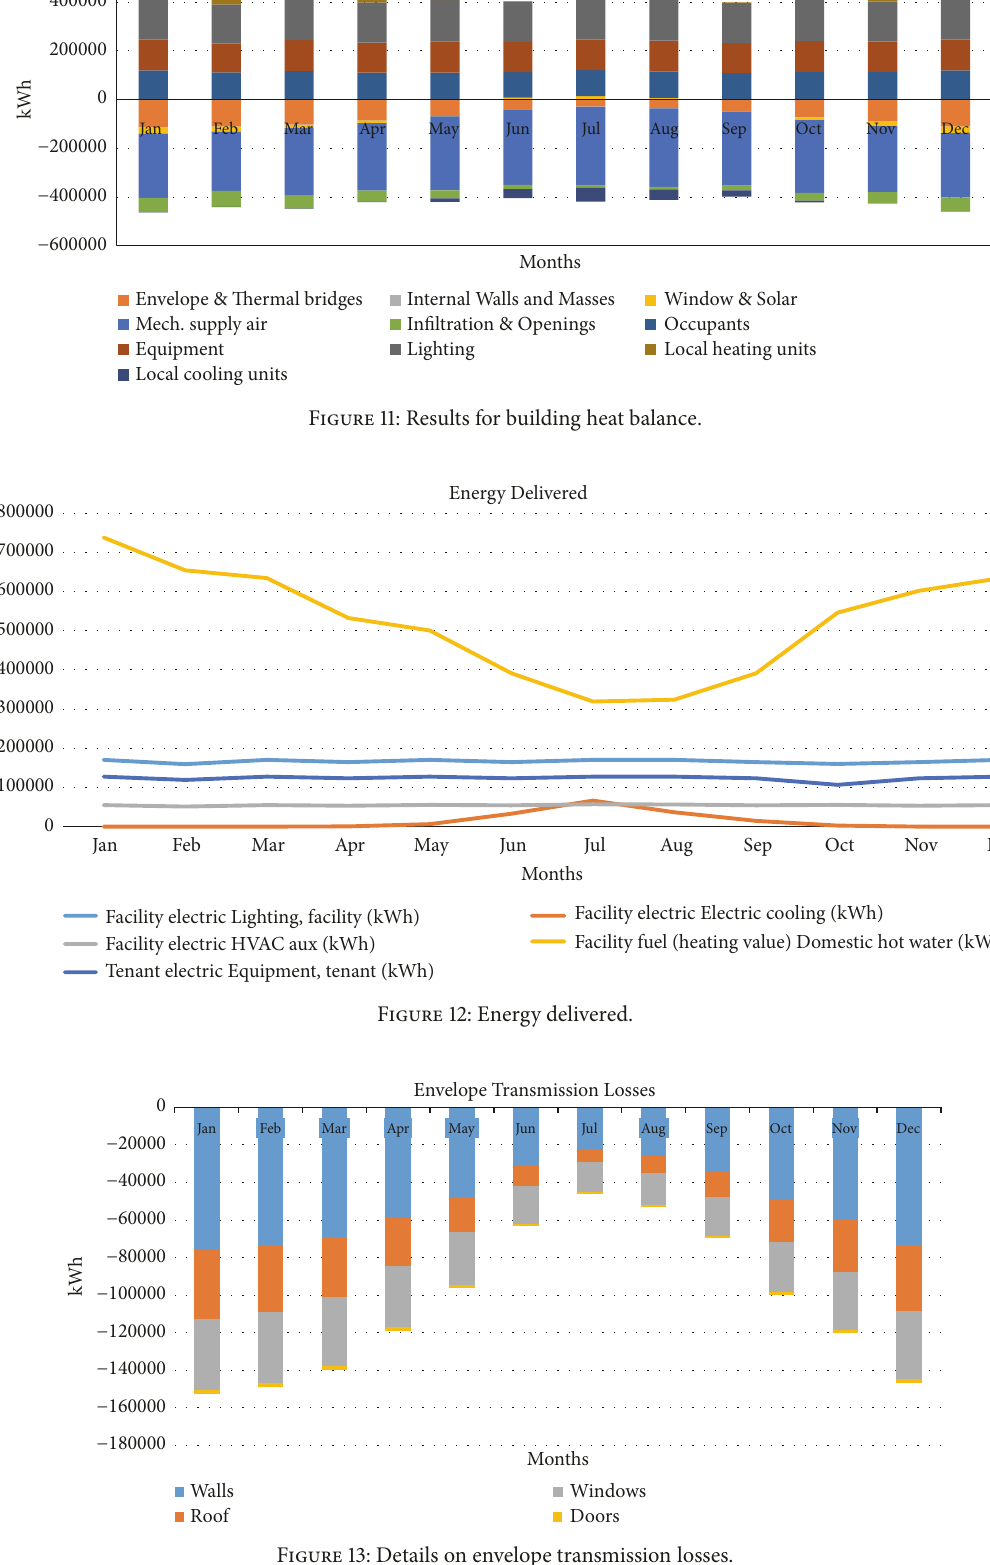
Figure 13: Details on envelope transmission